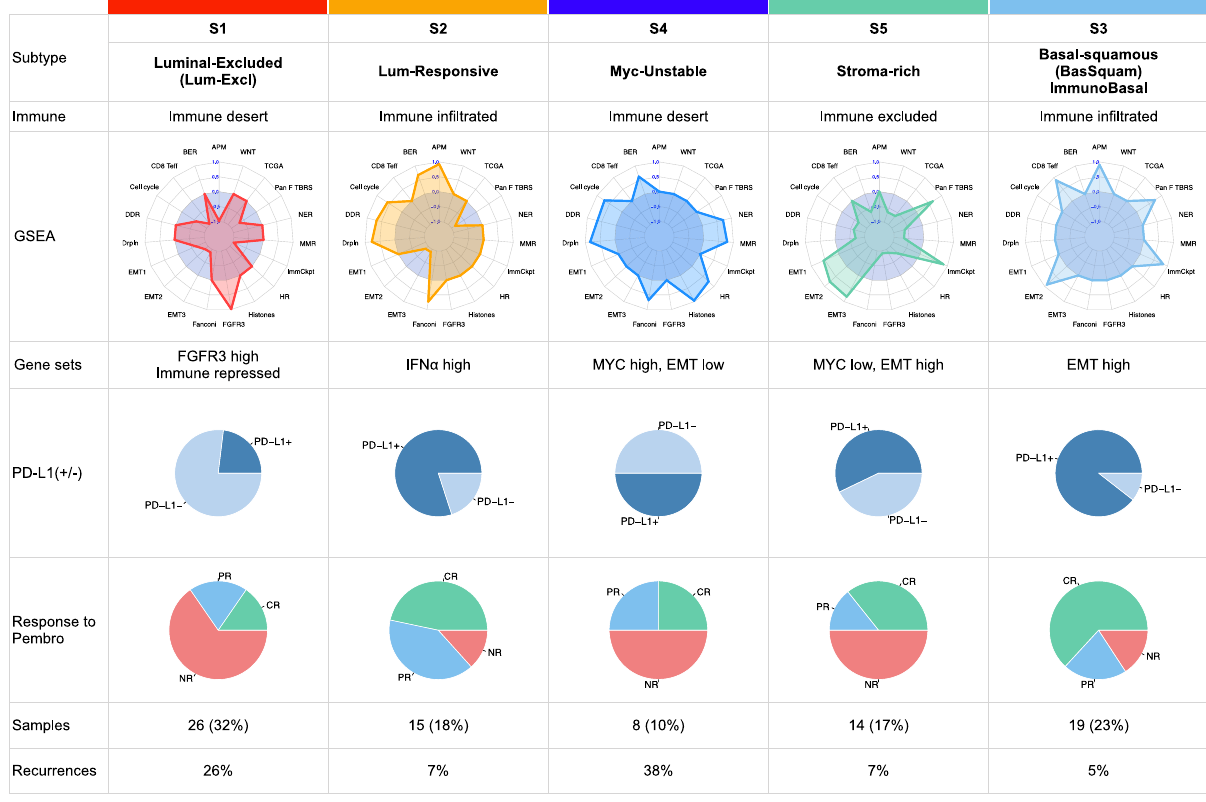
Fig. 7 | Summary characteristics of PURE-01 consensus expression subtypes. Top tobottom:clusternumber;subtypename;immuneclass(desert,in fi ltrated or excluded); GSEA signed areas under the curve (AUCs) for gene sets from Mar- iathasanetal.2018 20 ,positivevs.negativeAUCsindicateenrichedvs.repressedsets and AUC=0 indicates either that no result was returned from a CERNO 52 test with